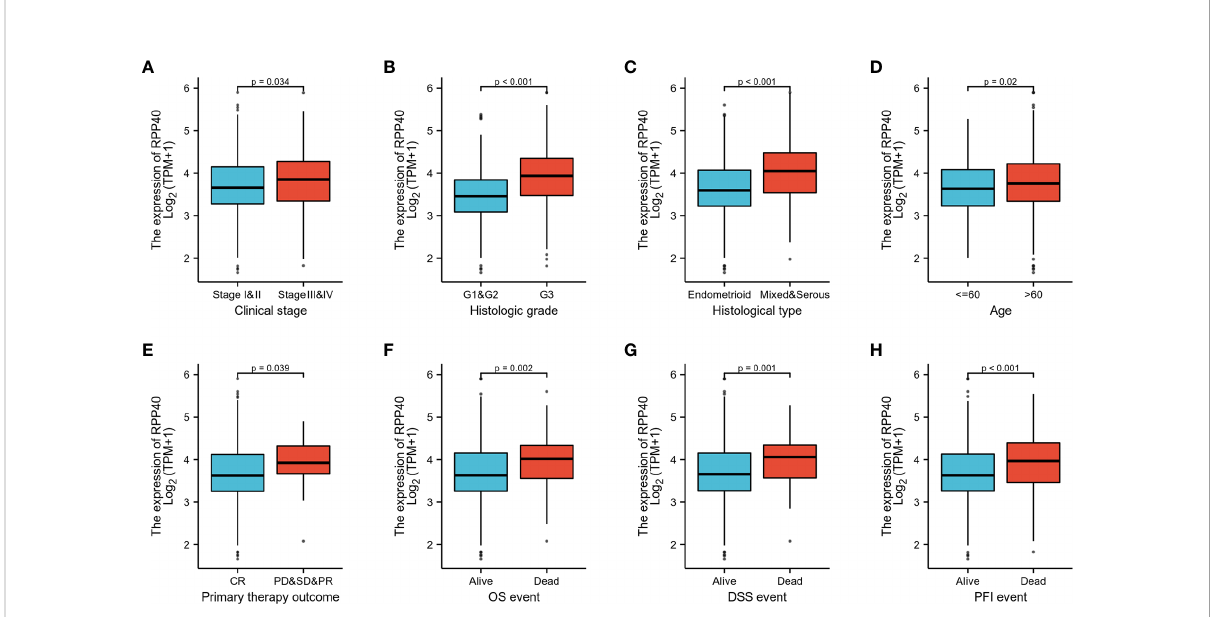
FIGURE 3 RPP40 expression is associated with clinicopathological characteristics in UCEC patients. The expression differences of RPP40 between distinct subgroups of UCEC patients are based on different clinicopathological characteristics, including clinical stage (A) , histological grade (B) , histological type (C) , age (D) , primary therapy outcome (E) , OS event (F) , DSS event (G) , and PFI event (H)